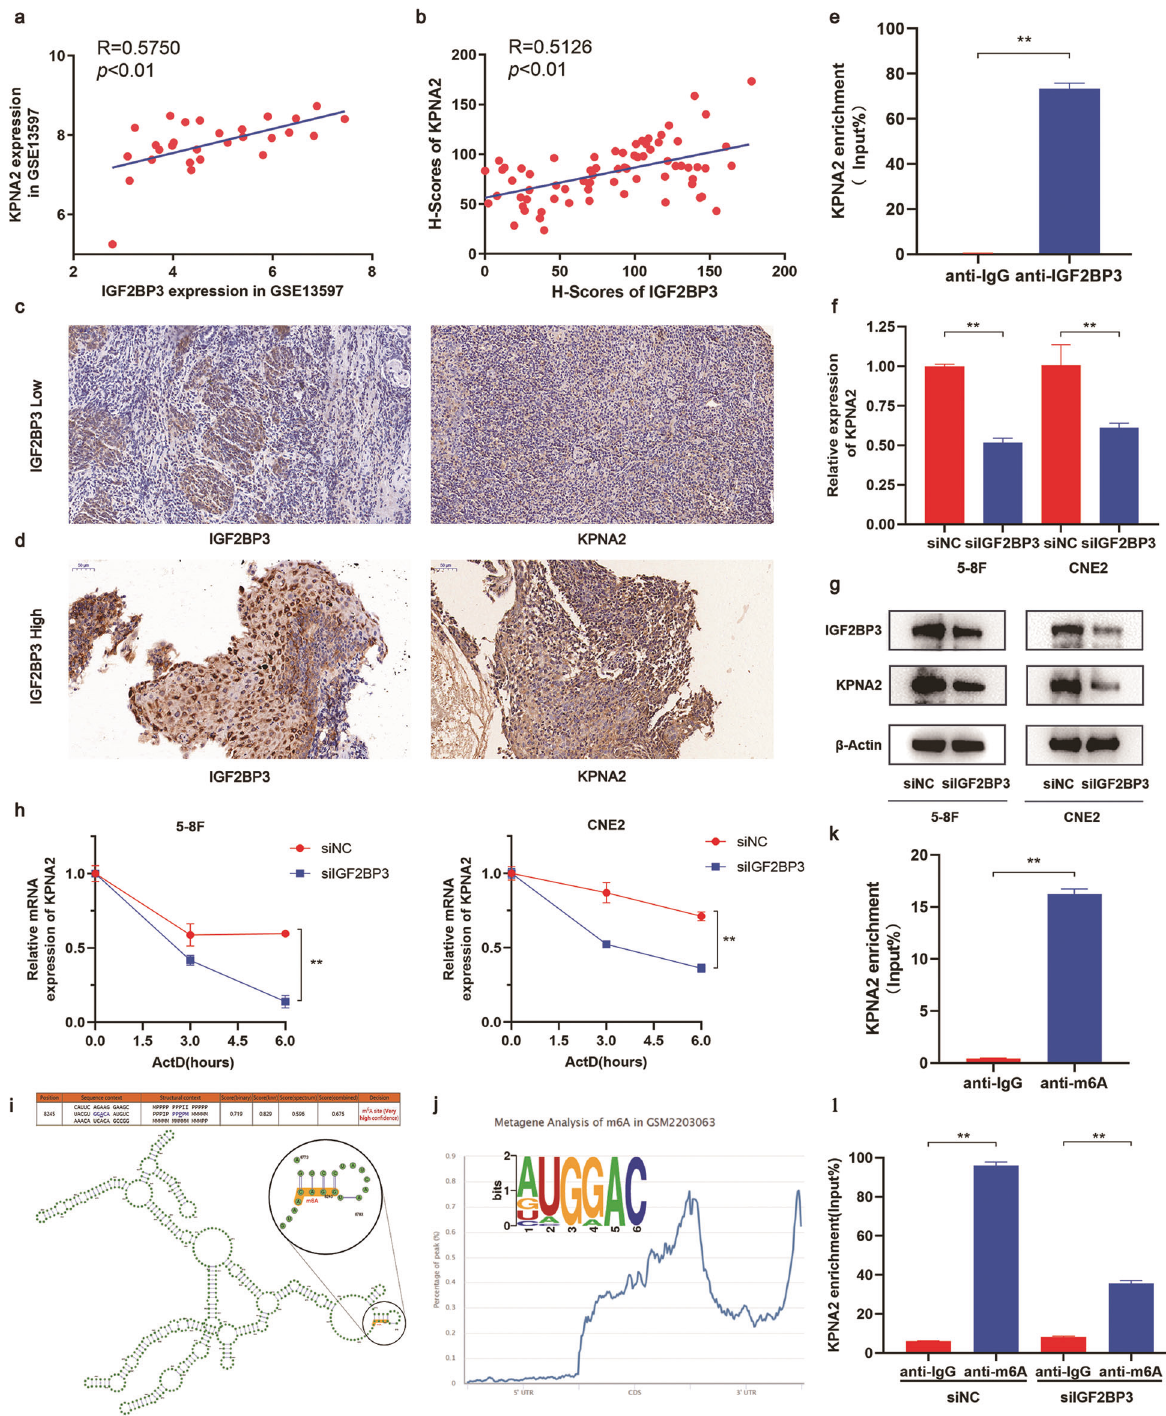
Fig. 4 IGF2BP3 regulates the mRNA stability of KPNA2 by reading its m6A modi fi cation site. a Correlation between IGF2BP3 and KPNA2 in GSE13597. b Correlation of H-score between IGF2BP3 and KPNA2 in immunohistochemistry. c , d IHC staining of IGF2BP3 and KPNA2 in IGF2BP3 low specimens ( c ) and IGF2BP3 high specimens ( d ). e RIP assay analysed KPNA2 enrichment in IGF2BP3 in NPC cells. The enrichment of RIP was normalized by input RNA via qRT-PCR. f , g qRT-PCR and western blot results of IGF2BP3 and KPNA2 mRNA and protein expression in 5 – 8 F and CNE2 cells after IGF2BP3 knockdown. h Treated transfected NPC cells with actinomycin D for indicated times, and the mRNA levels of KPNA2 were measured by qRT ‐ PCR. i Possible sequence and structure of m6A sites on KPNA2 transcripts predicted by SRAMP. j Motif display and metagene analysis of m6A sites on KPNA2 transcripts via RMBase V2.0. k MeRIP-qPCR analysis of KPNA2 mRNA. l MeRIP-qPCR analysis of KPNA2 mRNA after IGF2BP3 knockdown, compared to the negative control. Data was shown as the mean ± standard deviation of three independent experiments. ** P <